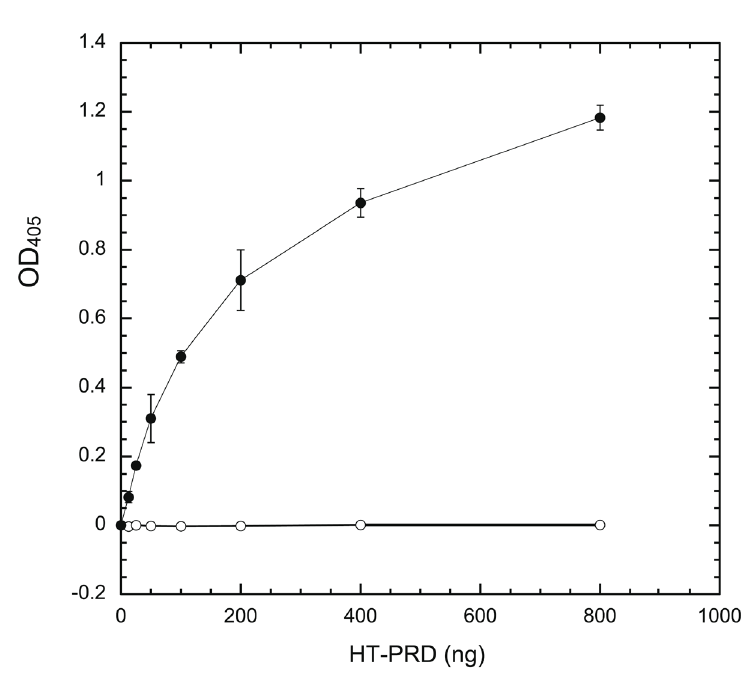
Figure 2. Phosphorylation of coated HT-PRD by DYRK1A. Wells were coated with indicated amounts of HT-PRD (0, 25, 50, 100, 200, 400, and 800 ng/well) and then subjected to extensive DYRK1A phosphorylation in situ by incubation with 80 ng of HT-497 at 30°C for 60 min. The level of S857 phosphorylation was then detected with 3D3 following the sandwich ELISA protocol, as described in Methods (n = 4 for each data point). Filled circles ( ● ), with kinase; empty circles ( ○ ), without